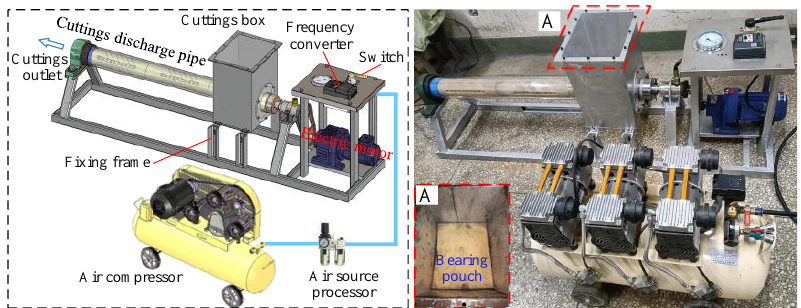
Figure 13. Equipment used in laboratory.